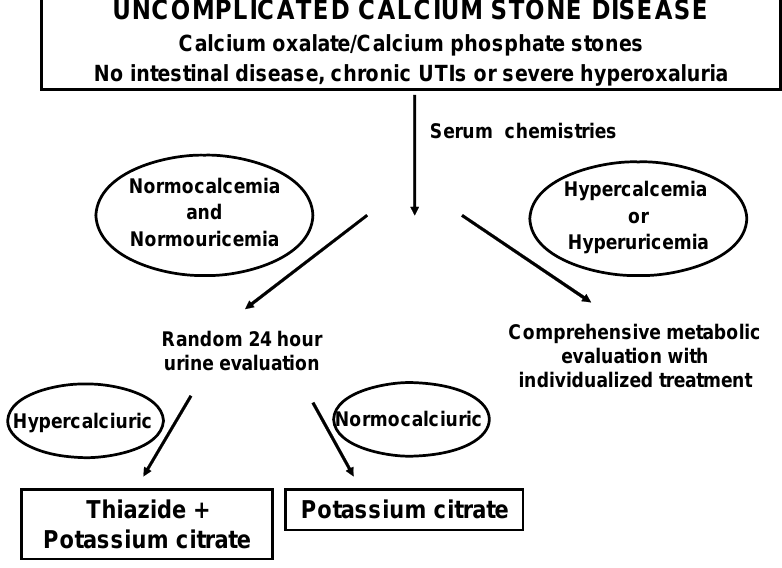
FIGURE 1. Algorithm for simplified approach to metabolic evaluation of uncomplicated calcium stone